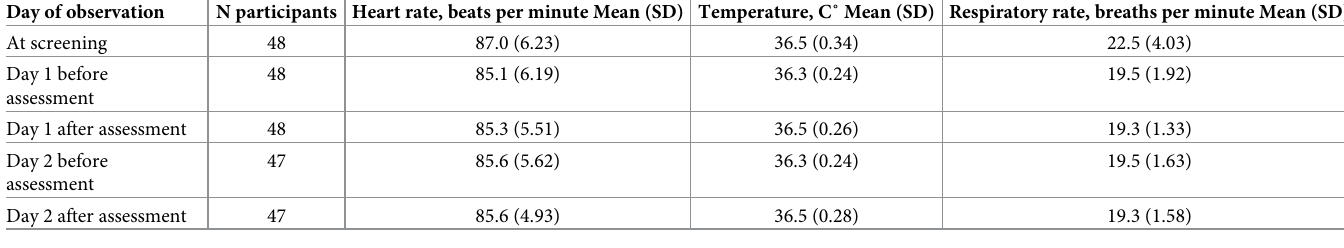
SD, standard deviation.